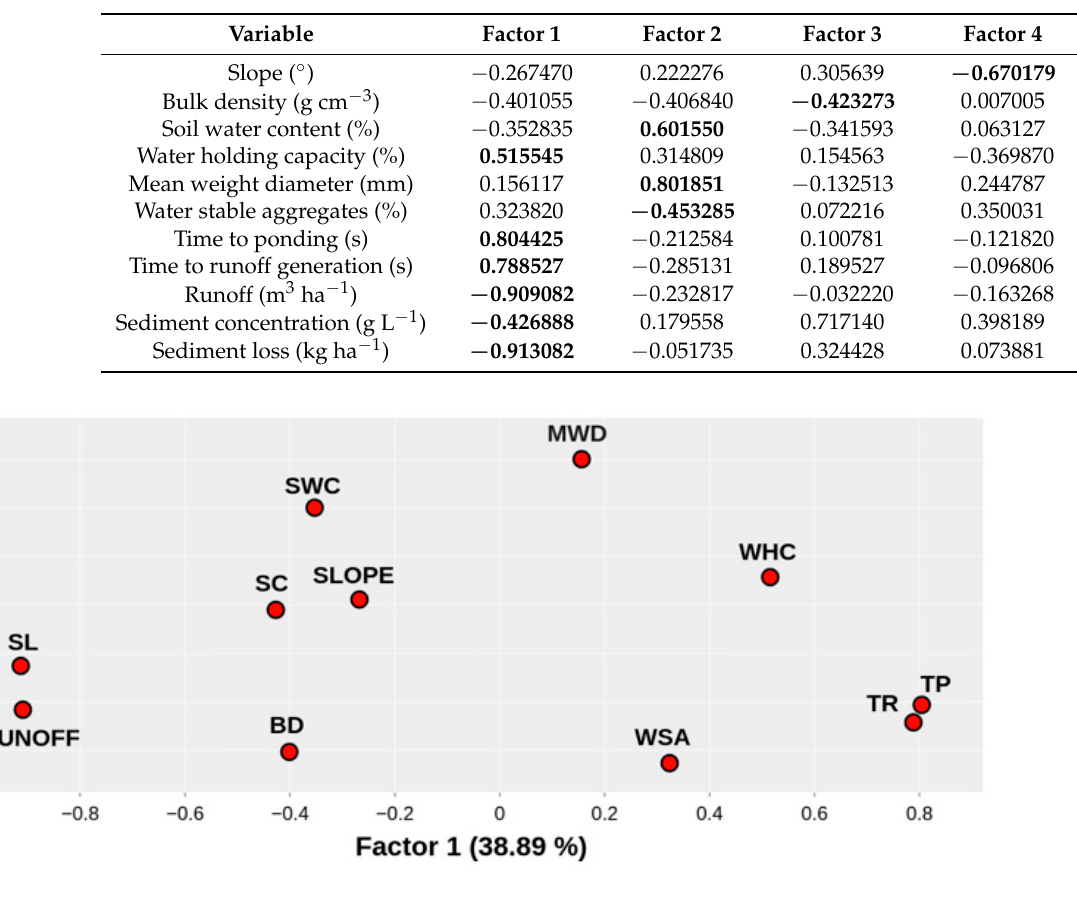
Table 4. Loadings matrix considering the first four factors extracted from the Principal Component Analysis. Eigenvalues retained in each factor are in bold.